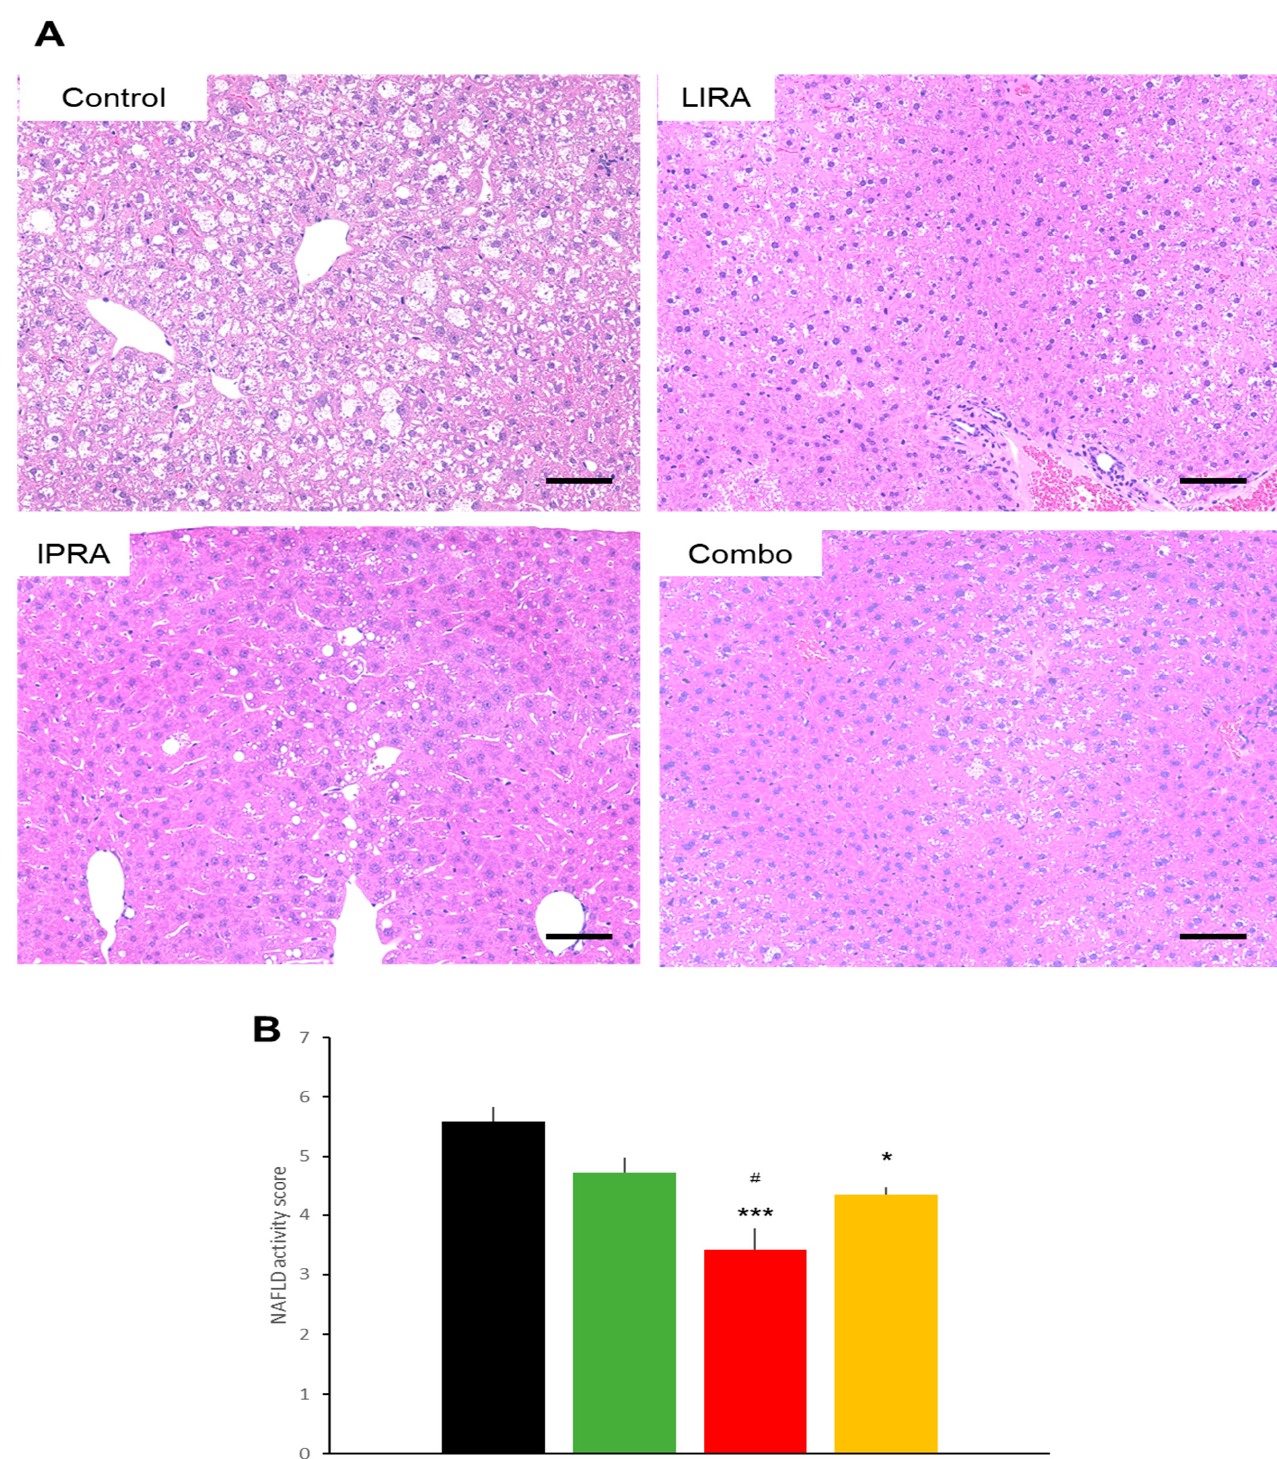
Figure 8. Effects of treatments with liraglutide and/or ipragliflozin on livers of db/db mice. Representative liver sections ( A ) and NAFLD activity score ( B ) of vehicle-treated db/db mice and of db/db mice treated with liraglutide and/or ipragliflozin. Data represent mean ± n = 6, * p < 0.05, and *** p < 0.001 vs. control group, # p < 0.05 vs. LIRA group. Scale bars = 100 µ